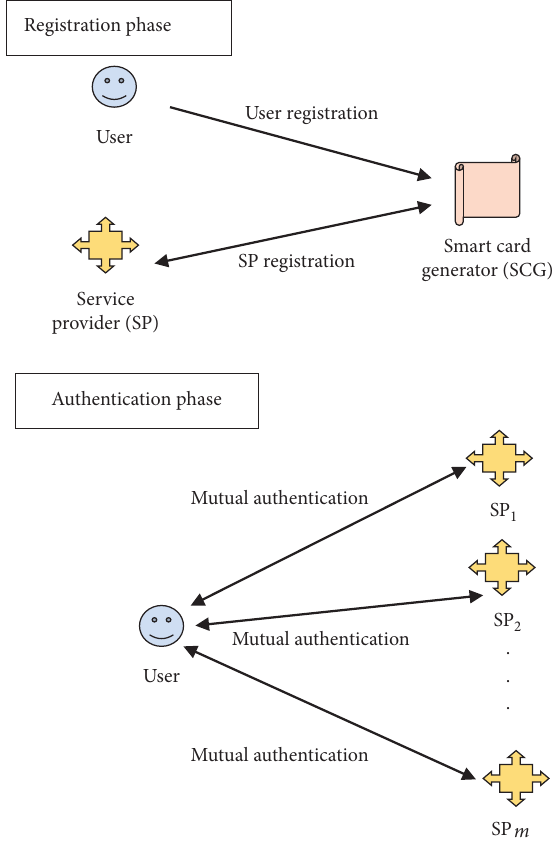
Figure 6: Authentication scheme framework for distributed MCC services